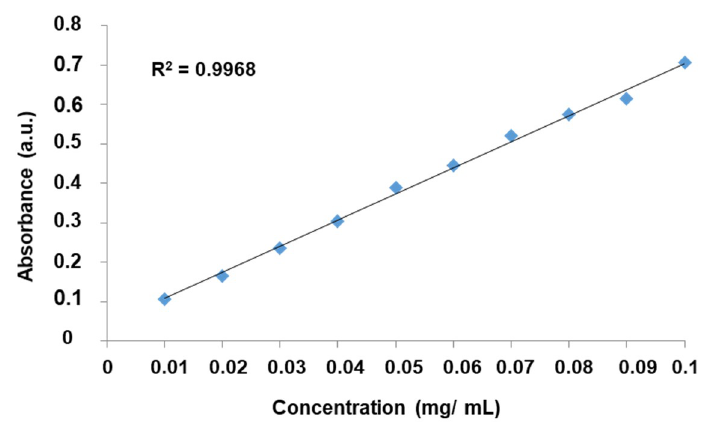
Figure 9. The standard calibration curve of L-DOPA in PBS.